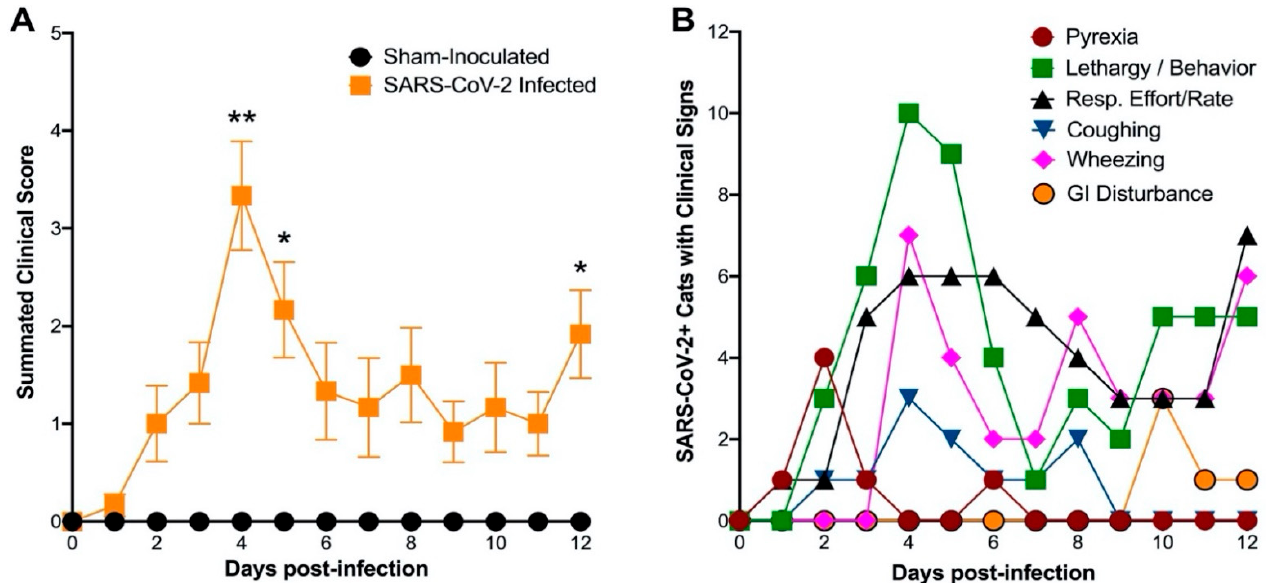
Figure 1. SARS-CoV-2 (Delta variant) infection results in clinical disease in domestic cats. Clinical parameters were assessed using a modified feline respiratory disease clinical scoring system (Table